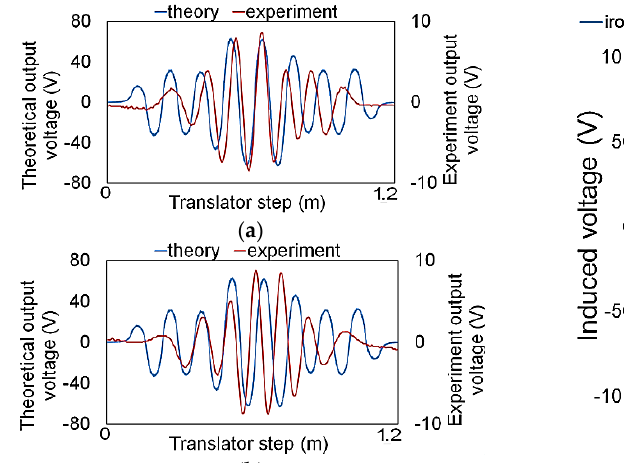
Figure 18. The graph of the induced voltage of the iron-cored LPMG under random wave with equal peak frequency, different significant wave heights of 1.5 m ( left ) and 4.5 m ( right ).